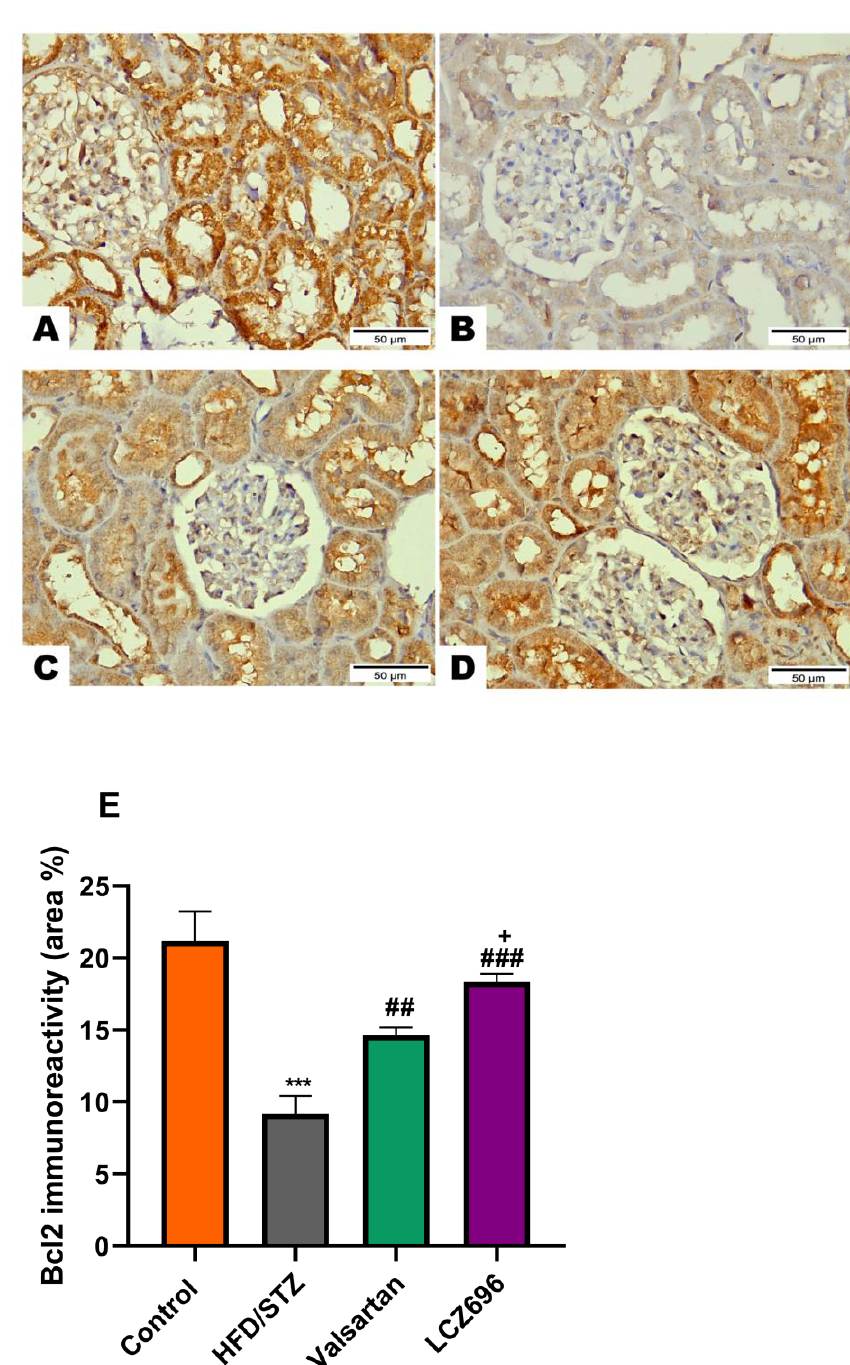
Figure 8. The effects of LCZ696 or valsartan on renal apoptosis marks in HFD/STZ-induced dia- betic rats. A representative photomicrograph of renal cortex showing Bcl-2 immunohistochemistry expression in different study groups. ( A ) control, ( B ) HFD/STZ, ( C ) valsartan-treated group, and ( D ) LCZ696-treated group. Area percent of immunoreactivity of Bcl-2 were quantified ( E ), ( n = 3); data are presented as mean ± SEM, *** p < 0.001 versus control; ## p < 0.01 and ### p < 0.001 versus HFD/STZ; + p < 0.01 versus valsartan (scale bar 50 µm).